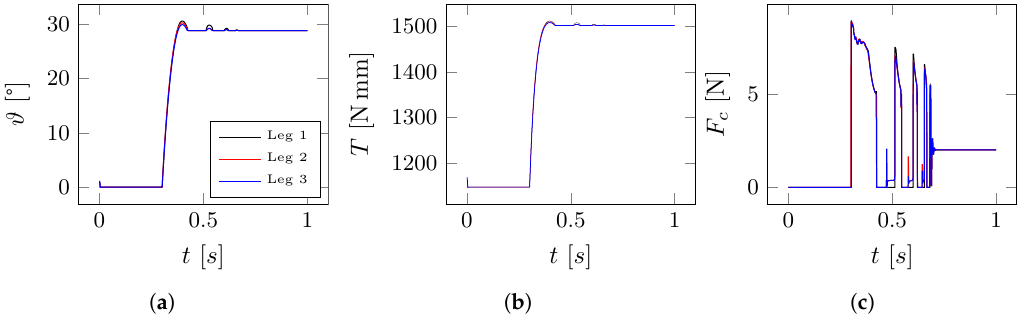
Figure 8. ( a ) The curves representing the angular rotation of each of the three leg structure revolute joint; ( b ) the curves representing the torque response of each of the three VRD’s; ( c ) the curves representing the contact force between each of the legs with the soil.